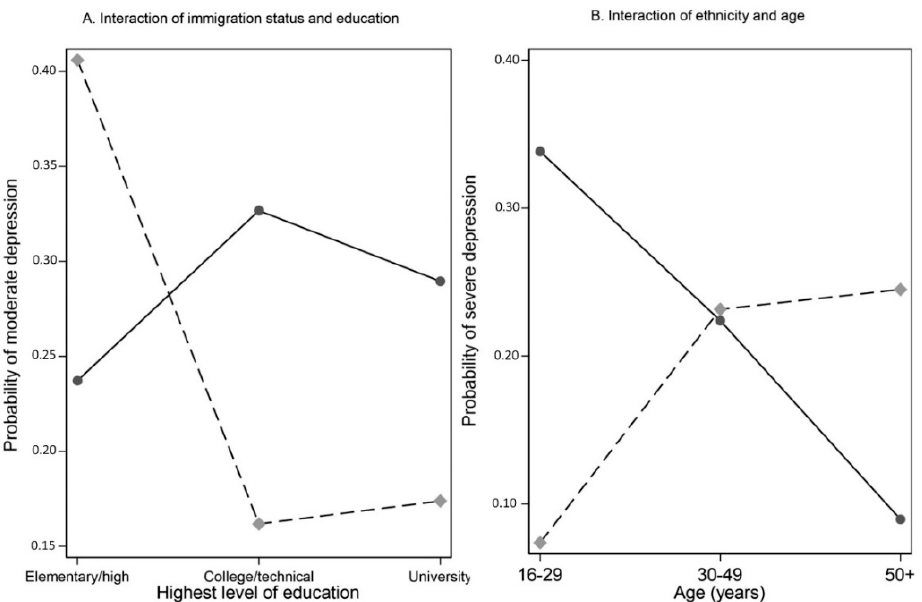
Figure 3. Interaction plots for depression: ( A ) moderate depression, education effects moderated by immigration status; and ( B ) severe depression, age effects moderated by ethnicity. Table 4. Factors associated with self-reported mental health support seeking behavior (needed support and received, needed but no access) compared to did not need and did not access, cycle 5 MHRC survey (1–8 February 2021),